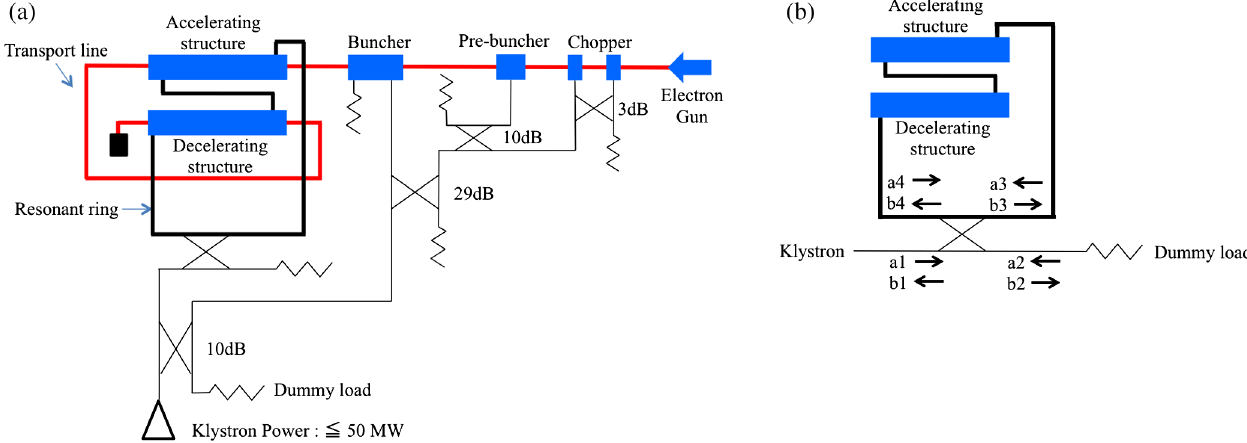
FIG. 3. (a) rf system of the PXR source and (b) the resonant